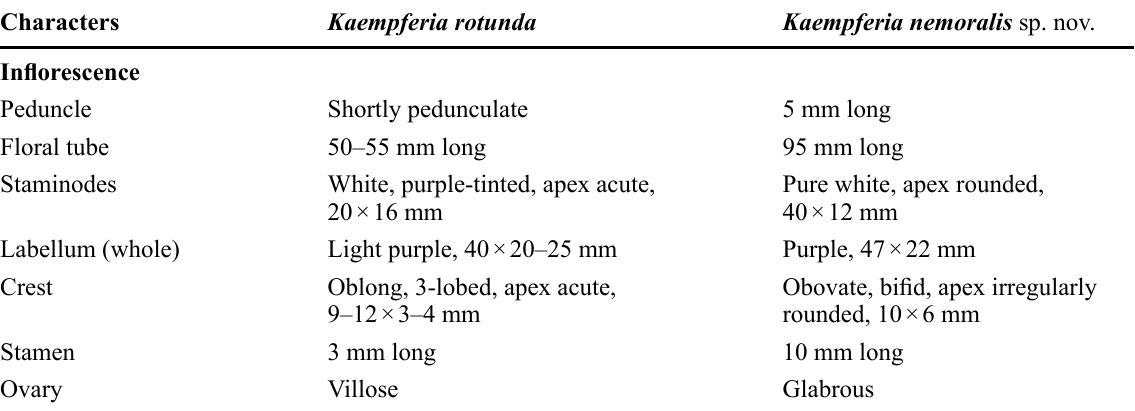
Table 2. Comparison of the floral parts of Kaempferia rotunda L. and Kaempferia nemoralis Insis. sp.